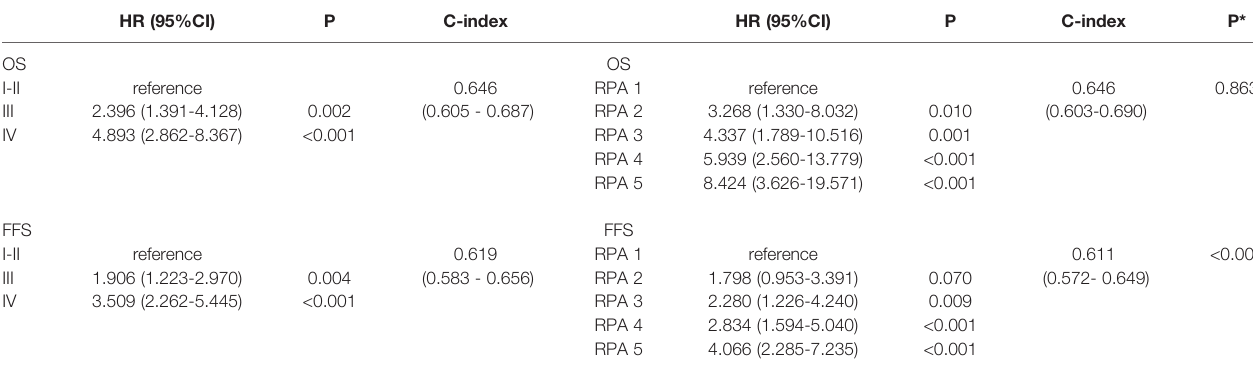
TABLE 4 | Univariate analysis for the overall stage and RPA classes associated with overall survival, and failure-free